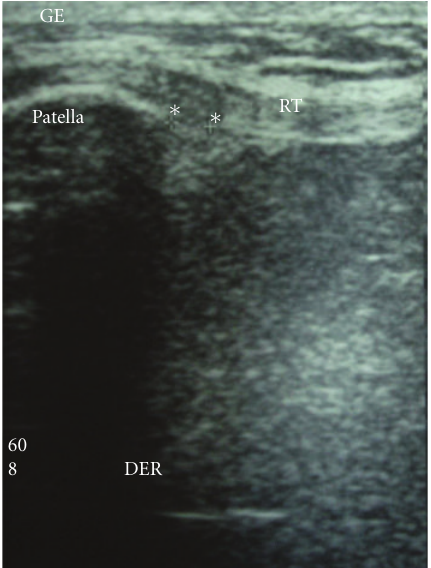
Figure 2: Preoperative US (ultrasound) of the patellar tendon showing areas of edema (hypoechoic) ( ∗∗ ). RT: rotulian or patellar tendon.